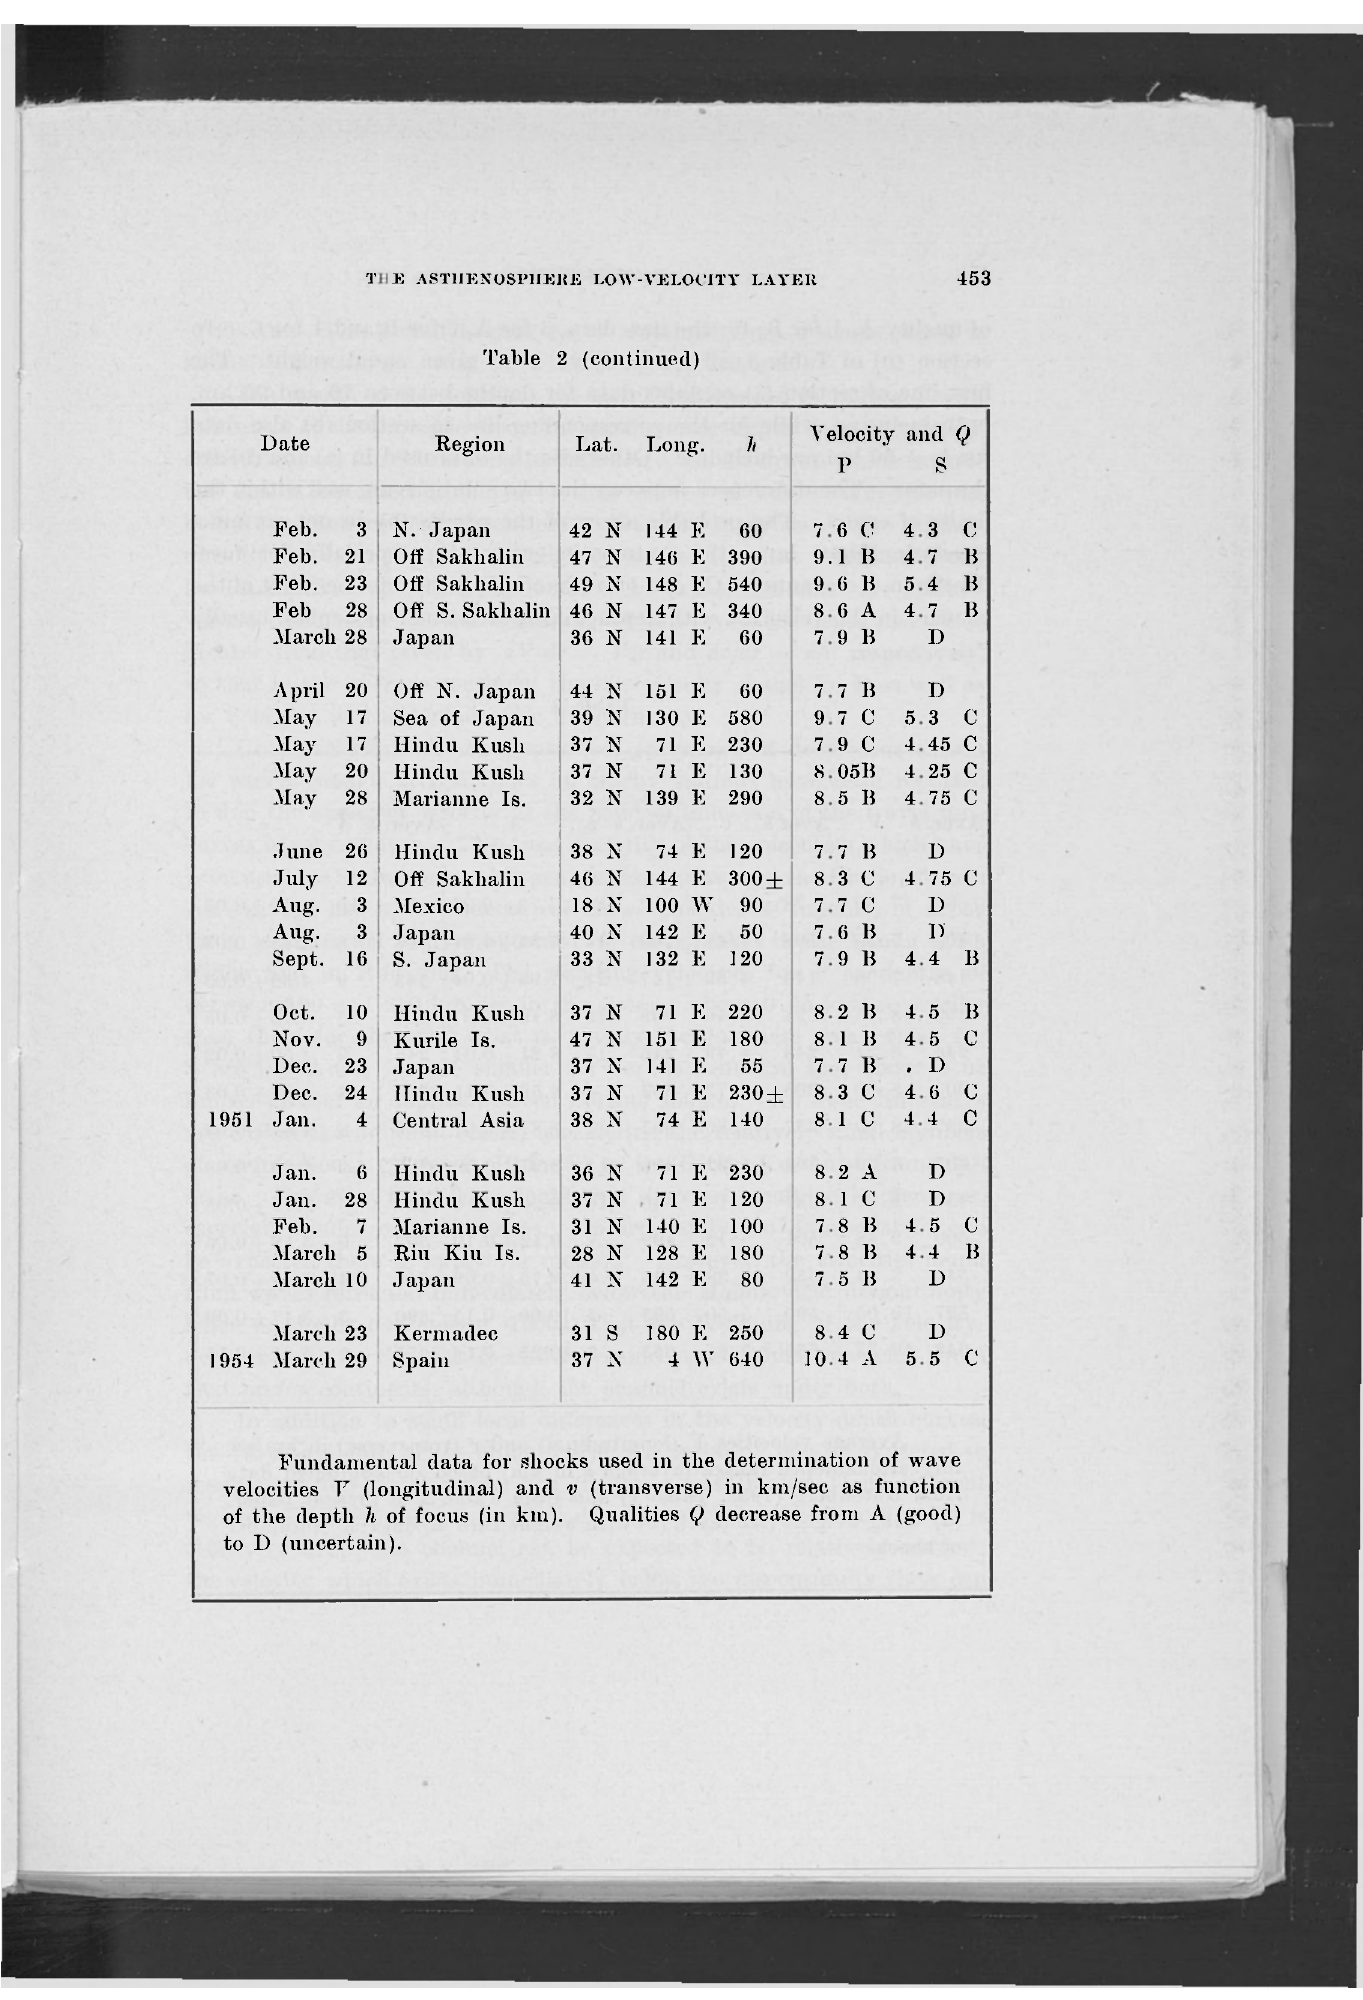
Fundamental data for shocks used in the determination of wave velocities V (longitudinal) and v (transverse) in km/sec as function of the depth h of focus (in km). Qualities Q decrease from A (good) to D